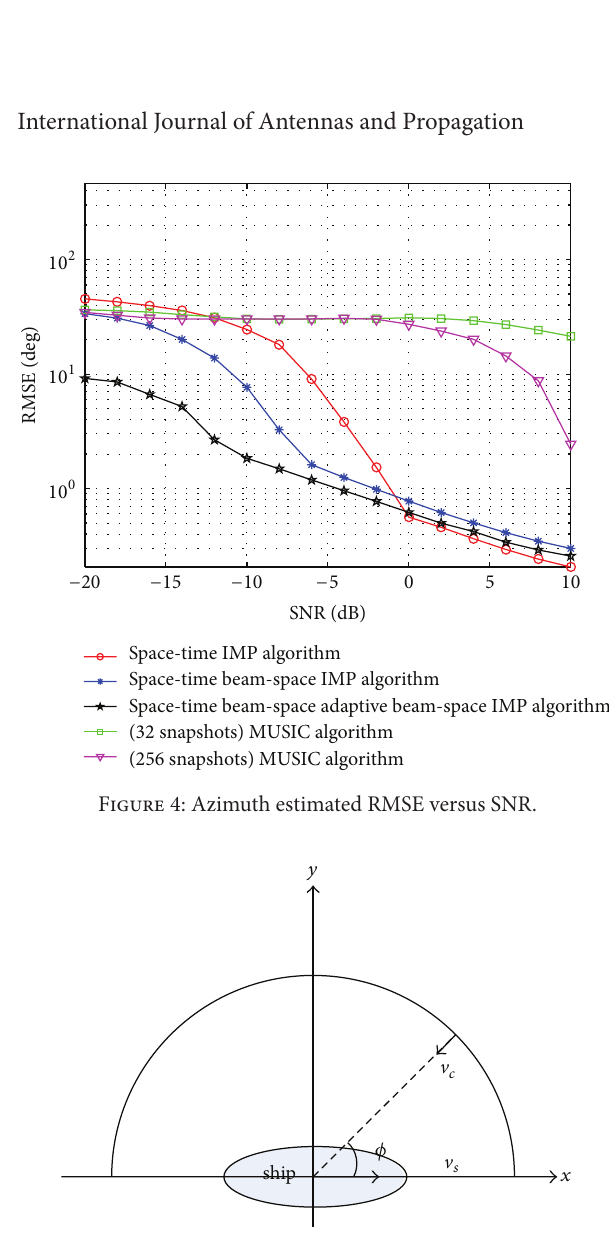
Figure 5: Schematic of shipborne HFSWR and current vector.